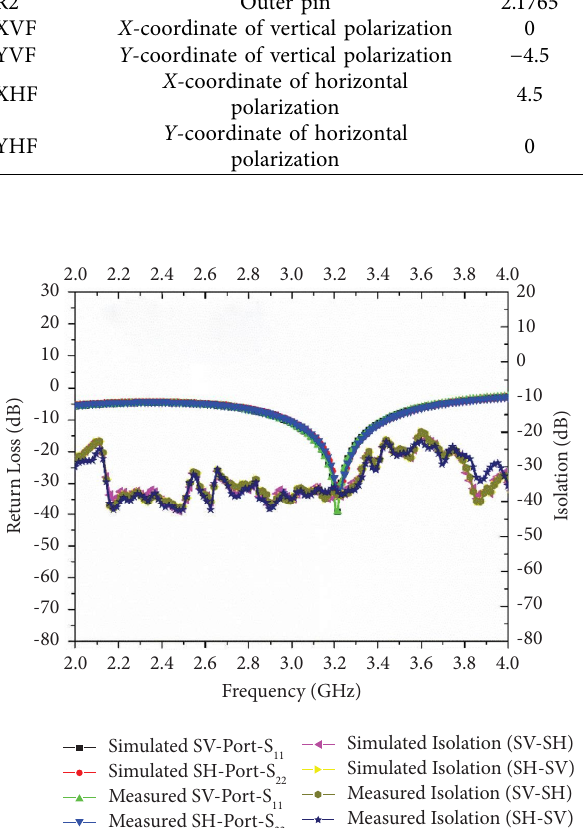
Figure 3: Frequency versus return loss and isolation of SV and SH-